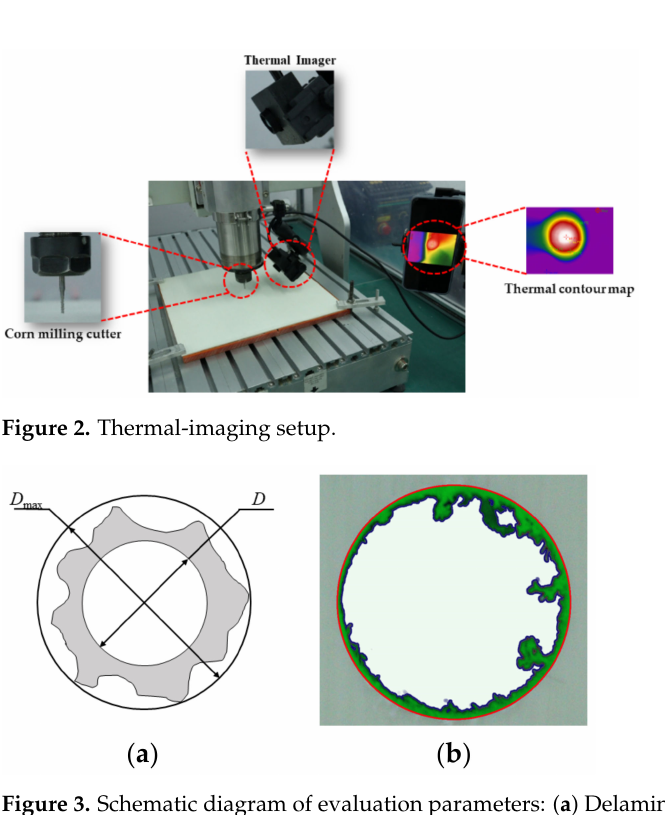
Figure 3. Schematic diagram of evaluation parameters: ( a ) Delamination factor; ( b ) Burr area.